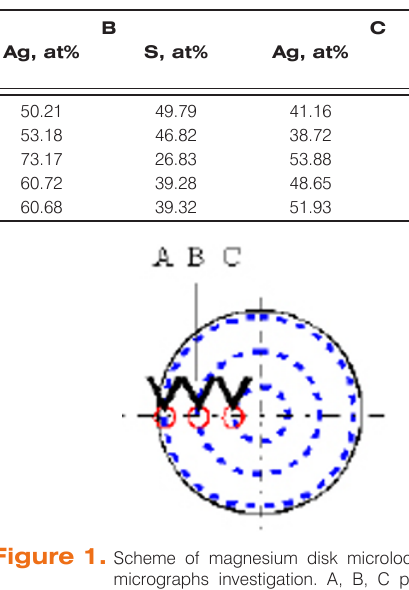
Table 1. Content of silver and sulfur in cemented deposits at A,B and C positions of magnesium disk after total silver cementation ( ≥ 99